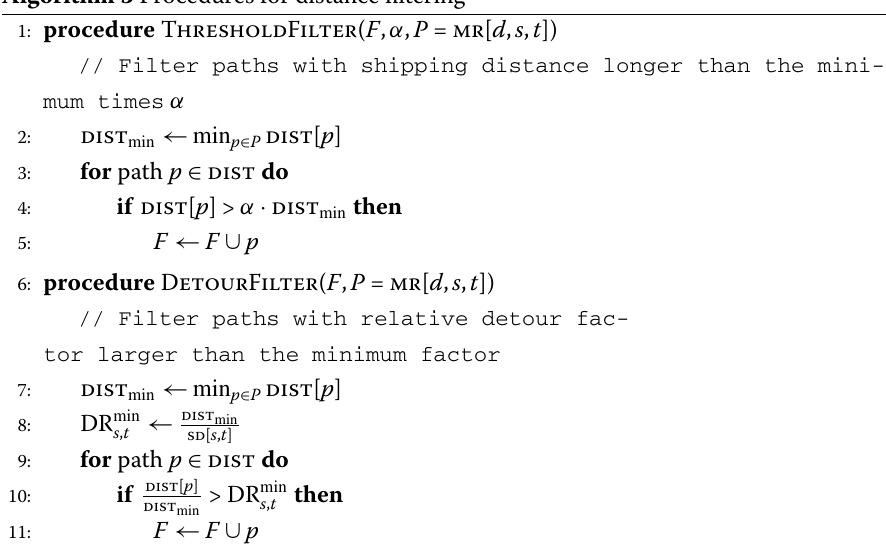
Algorithm 3 Procedures for distance